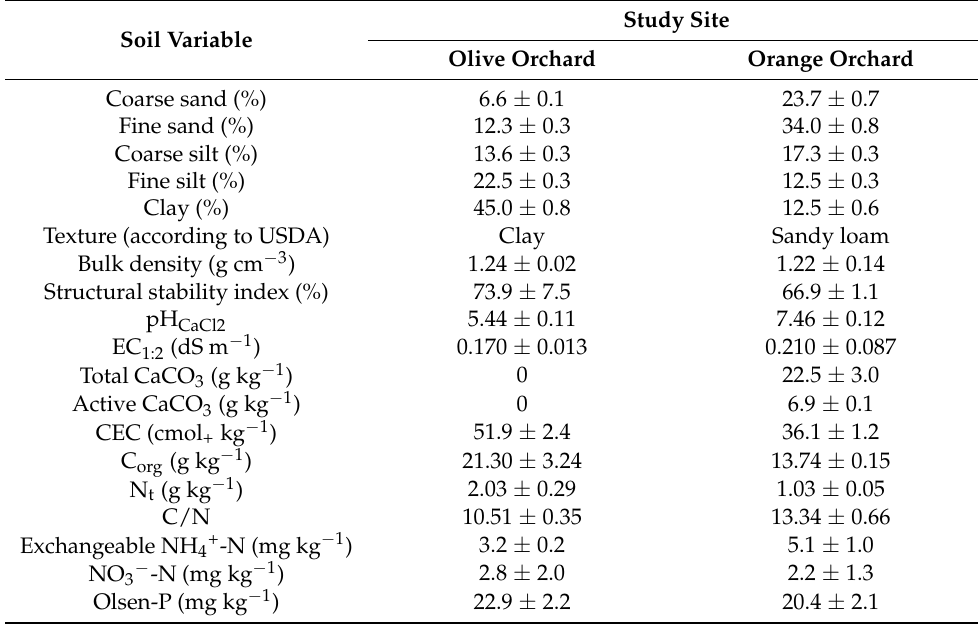
Table 2. Main physical and chemical properties of tested soils from the two study sites. Values are means ( ± SD, n = 4) expressed on a dry matter basis. Study Site Soil Variable Olive Orchard Orange Orchard Coarse sand (%)